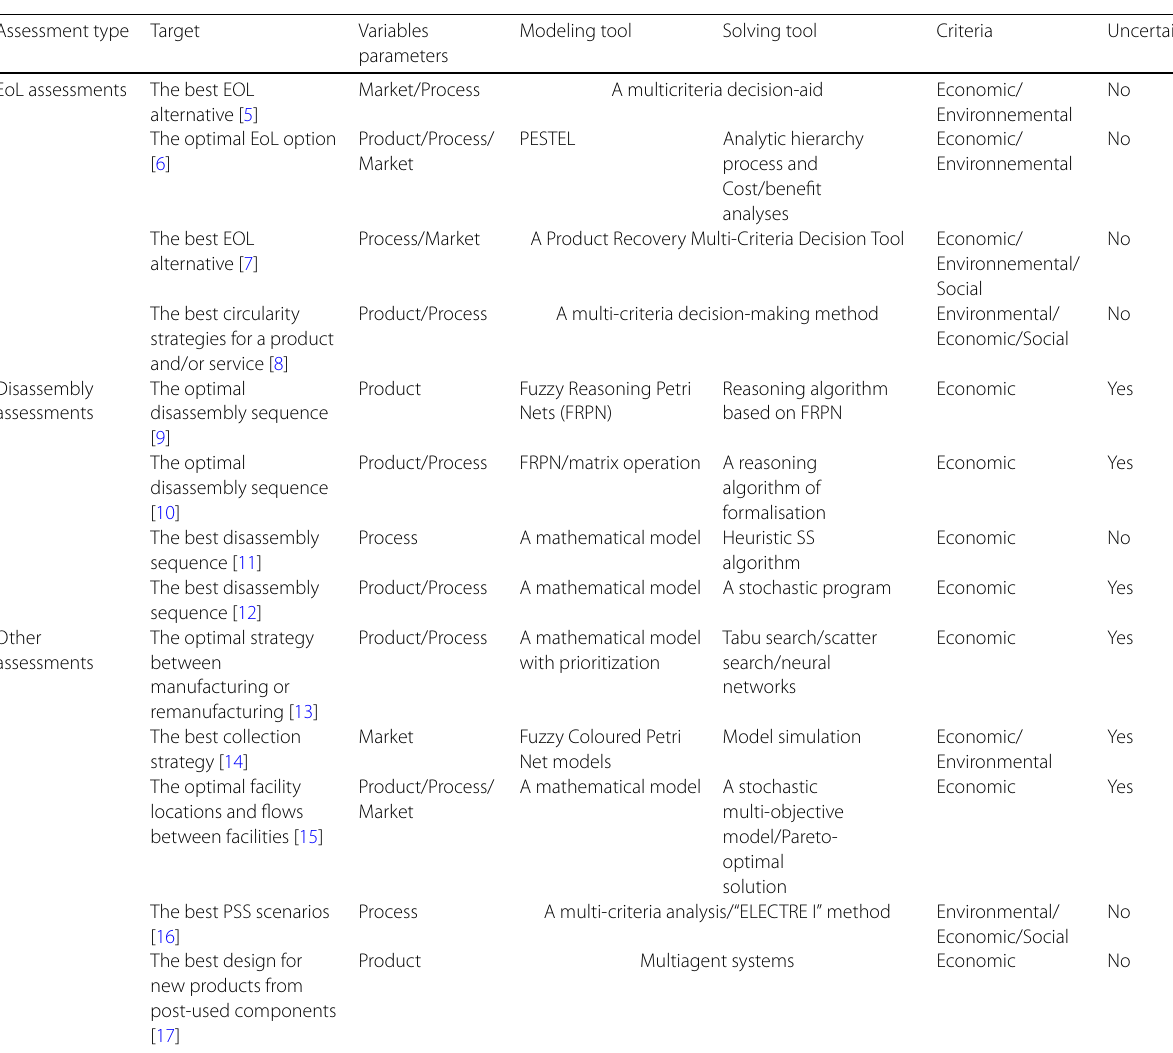
Table 1 End-of-life decision-making methods in literature Assessment type